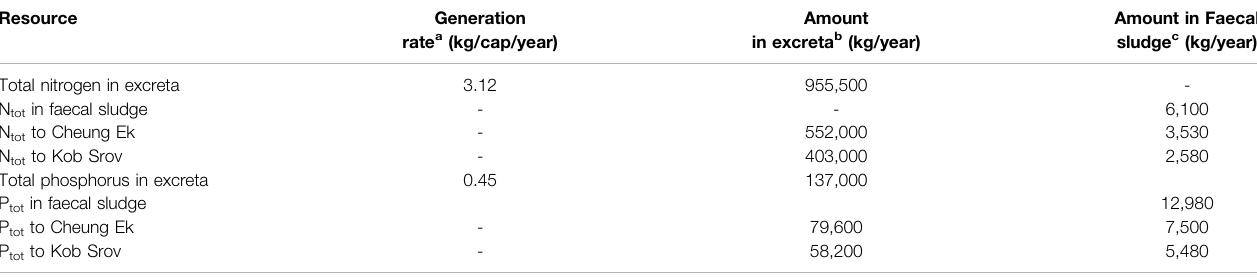
TABLE 4 | Estimated amounts of resources (total nitrogen (N tot ) and total phosphorus (P tot )) contained in excreta (urine + faeces) and in faecal sludge generated annually in Phnom Penh and discharged to Cheung Ek wetland and Kob Srov